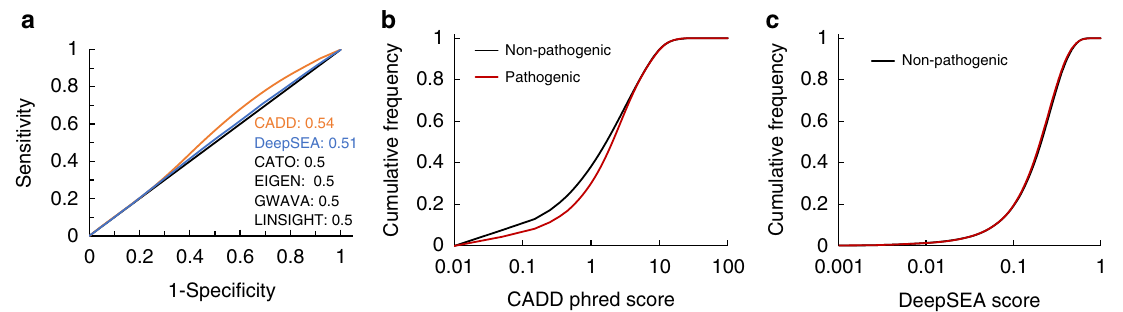
Fig. 1 Performance of tested methods on detecting pathogenic variant in position-matched ncSNVs. a ROC curves with AUROC values displayed for each method. b Cumulative distribution of CADD scores. c Cumulative distribution of DeepSEA scores. Pathogenic ncSNVs were limited to variants not observed in human or any of the 57 non-human